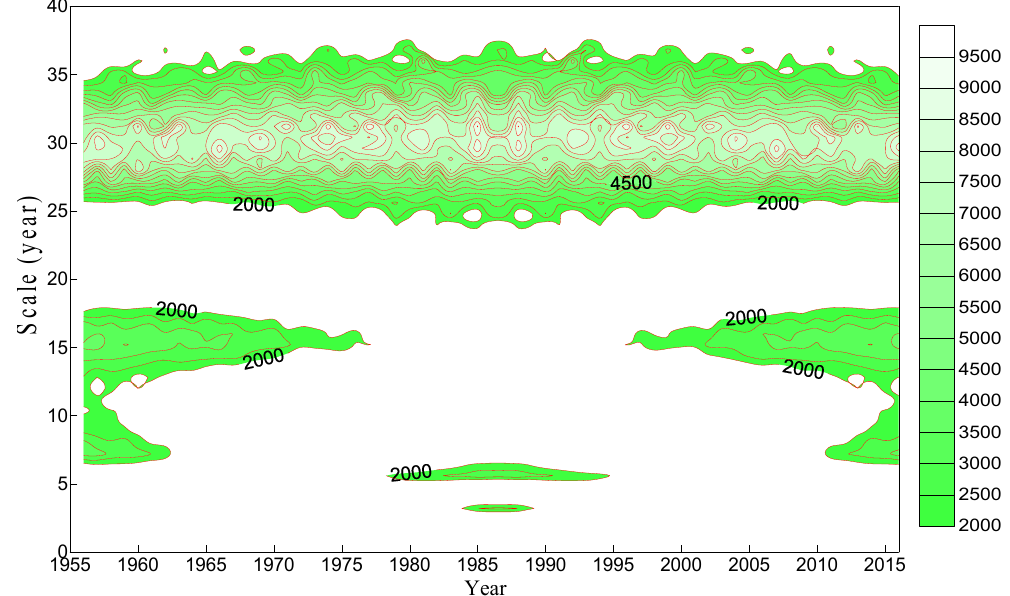
Figure 9. Modulus square of wavelet coefficient contour map of streamflow at Toudaoguai station.